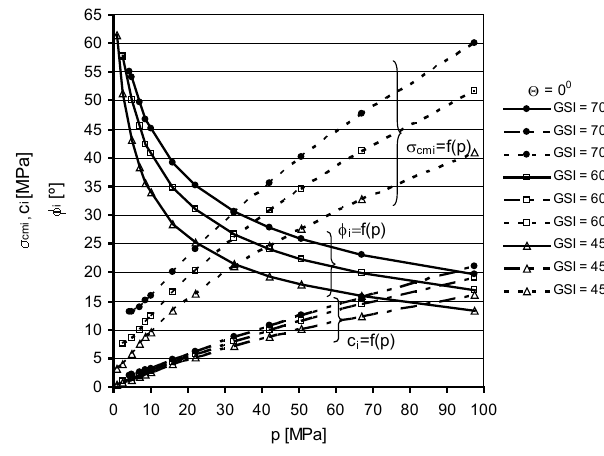
Fig. 3. Dependence of instantaneous global value of compressive strength σ cmi , cohesion c i and angle of internal friction ϕ i of the rock mass on the value GSI and hydrostatic pressure p